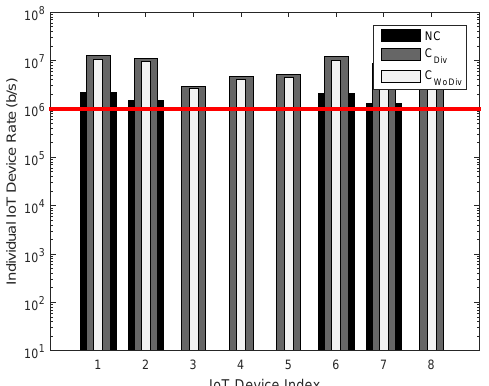
Figure 11. Individual device achieved data rate with respect to different number of total devices, with six relays and minimum device data rate of 1 Mbps.